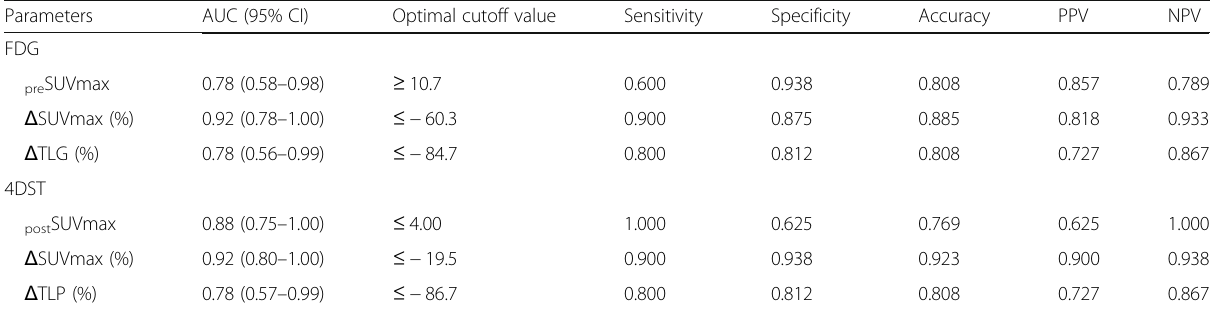
Table 4 ROC analysis for discriminating responders from non-responders using FDG and 4DST PET parameters Parameters